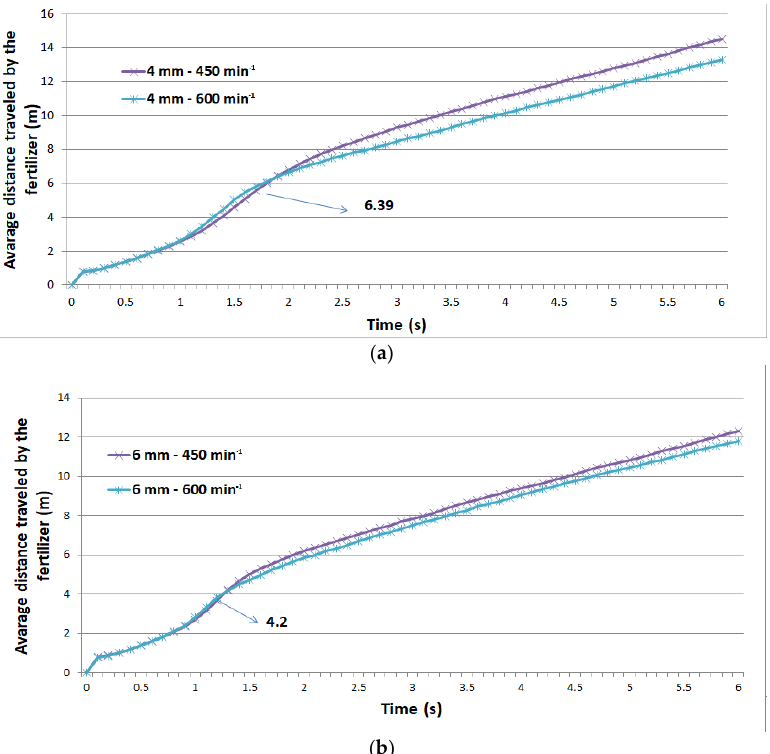
Figure 6. Average distance traveled by the particles of fertilizer I ( a ) and fertilizer II ( b ), when the discharge flow rate was 400 g s − 1 .